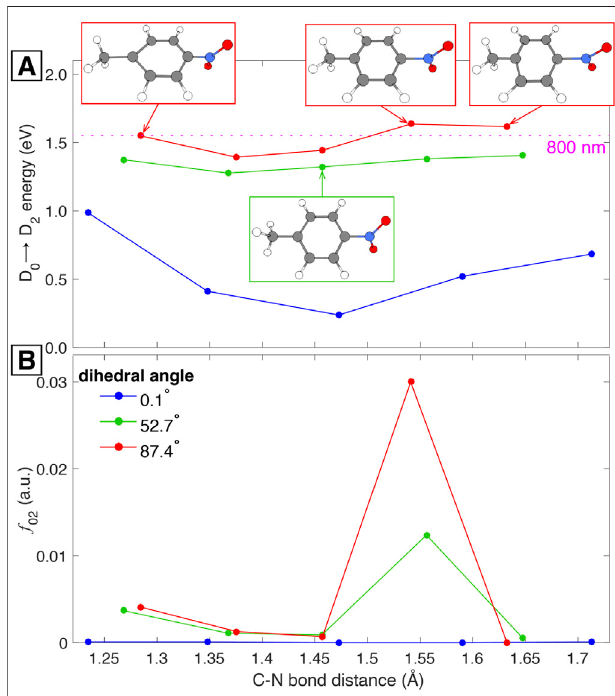
FIGURE 5 | Computed potential energy surfaces (A) and oscillator strengths (B) for PNT + along C – N bond distance under different C – C – N – O dihedral